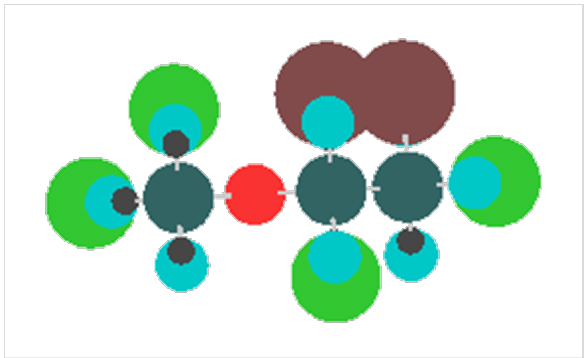
Figure 2: Superimposed chemical structures used to generate the MIA descriptors with atoms colored according to the corresponding Pauling’s electronegativity.